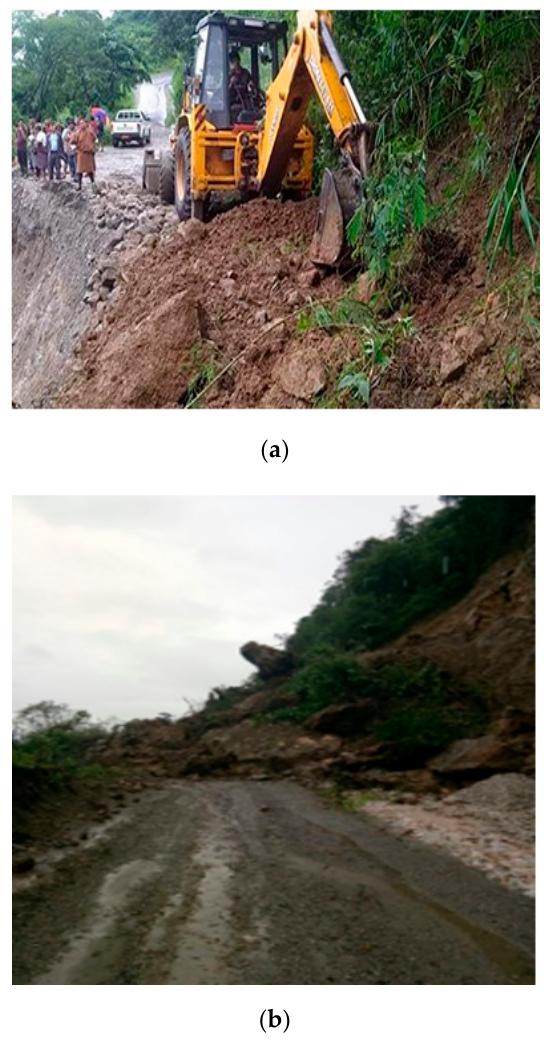
Figure 2. Landslide damage: ( a ) landslide at 68.1 km along the Samdrup Jongkar–Trashigang (S-T) road (N 26.903°, E 91.505°) (5 July 2016); ( b ) landslide at 93.8 km along the S-T road (N 27.112°, E 91.544°) (17 July 2016) [36] .